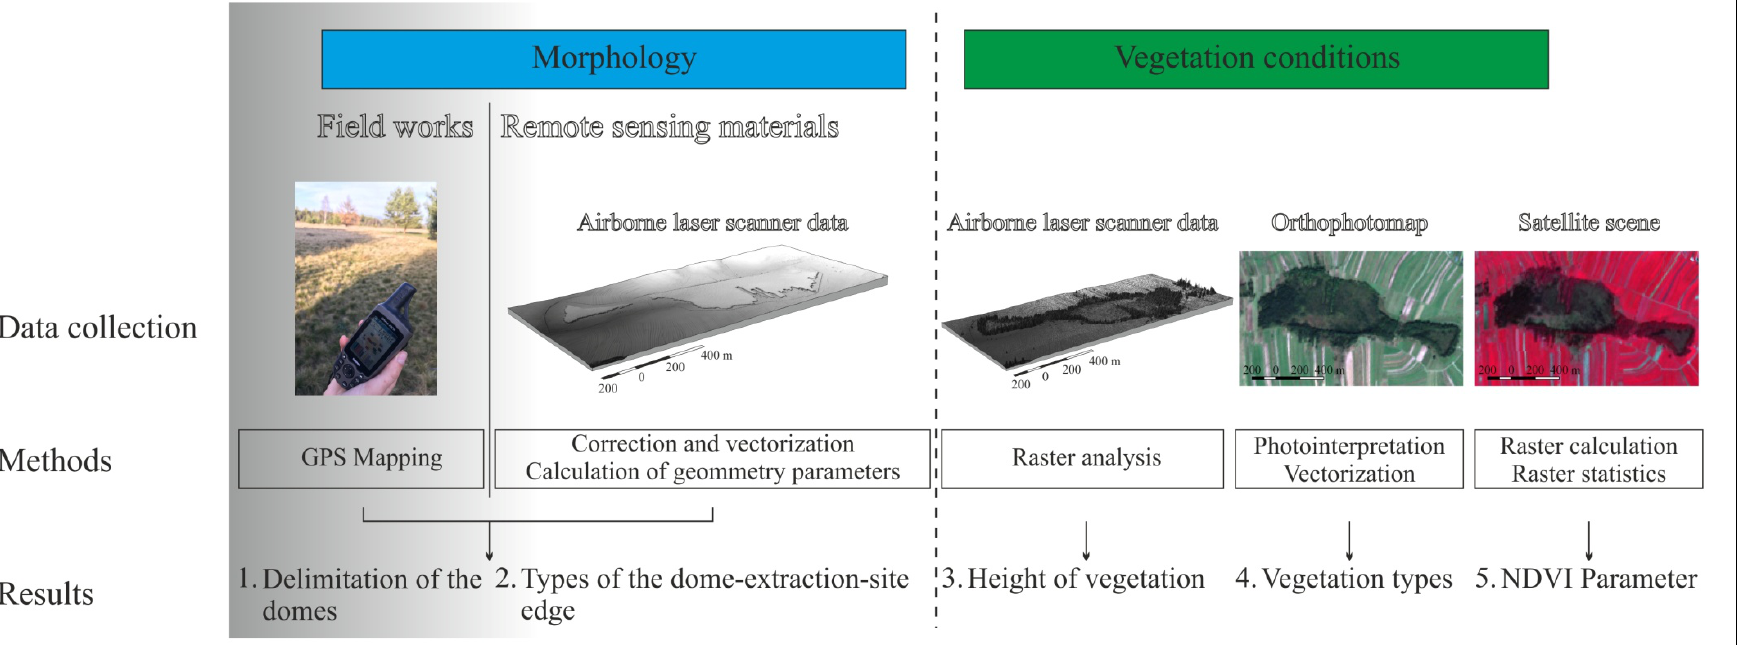
Figure A3. Scheme of fieldwork and desk studies contributing to the article.